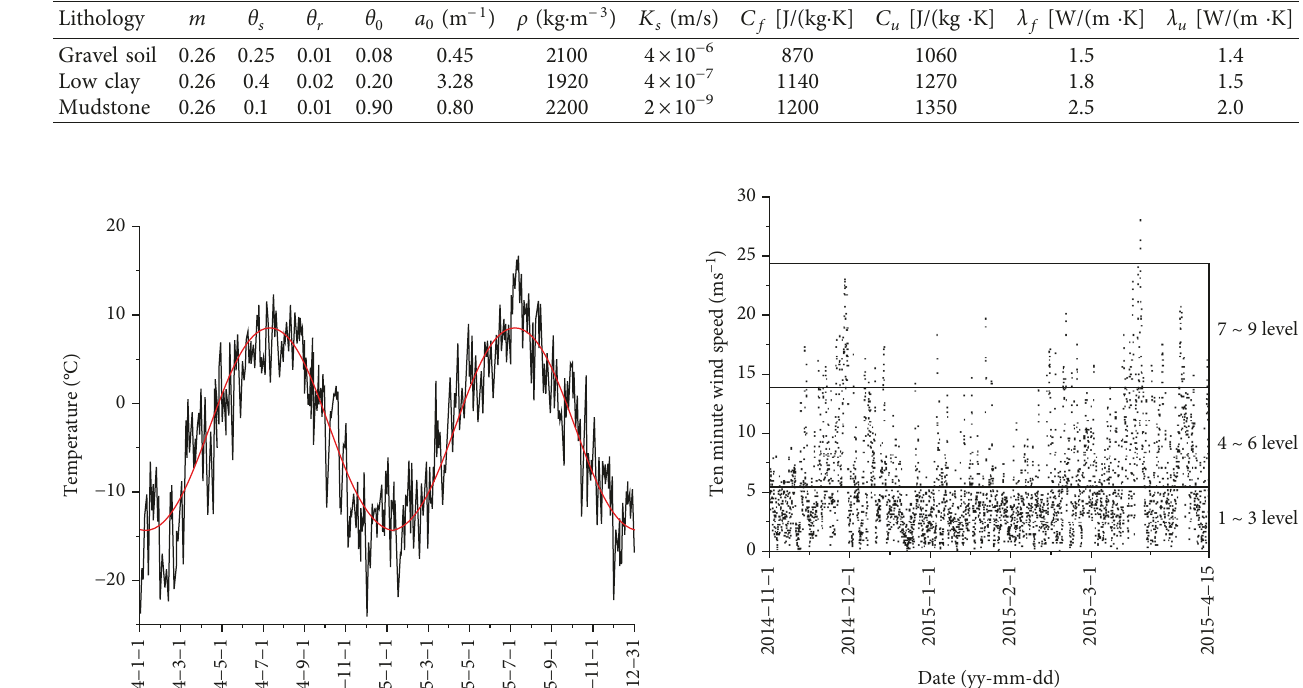
Table 3: Main parameters of roadbed model.